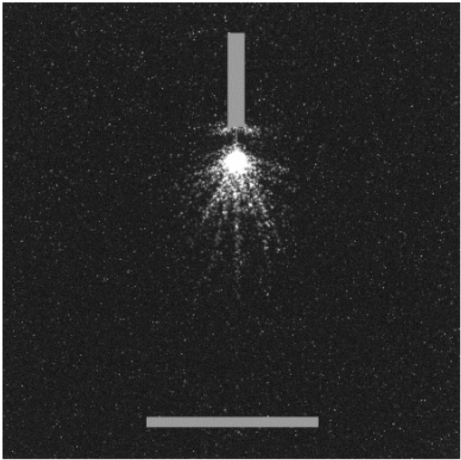
Figure 16. Photo (experiments) [31] of streamer discharges in SF 6 at 0.1 bar in point to plane configuration. Needle radius of curvature = 0.2 mm, gap distance = 50 mm. Applied voltage = 37